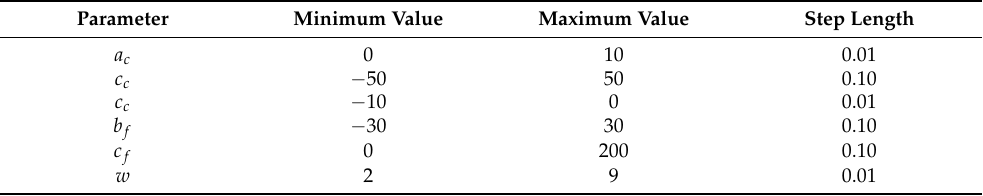
Table 1. The boundaries of the parameter space and the step length 1 used for the first estimation. Parameter Minimum